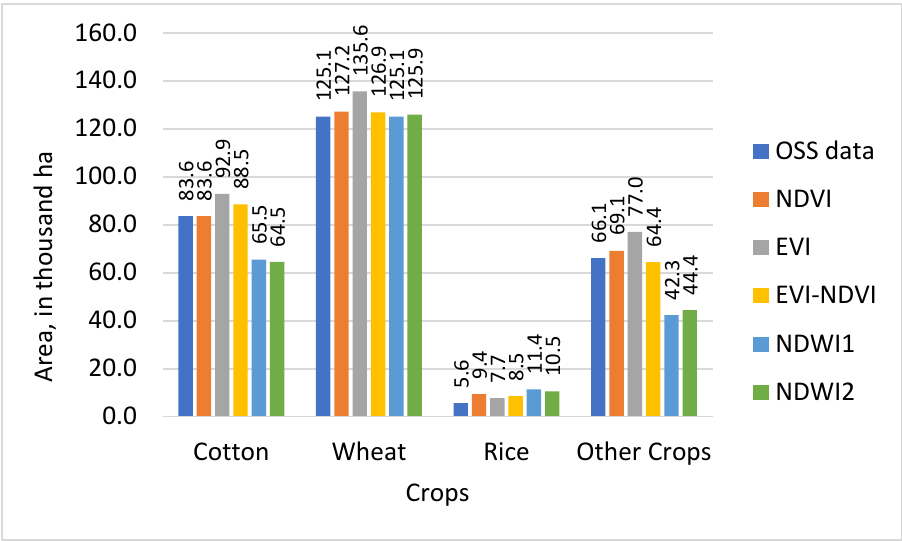
Figure 7. Comparison of classified crop types area with OSS data for SVM classifier with S2 sen- sor.